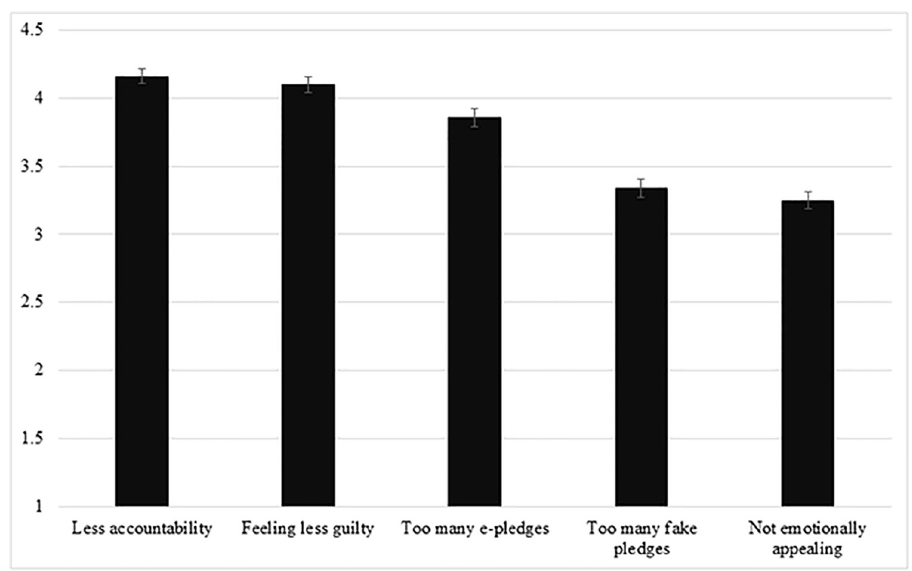
Fig 1. Ratings of factors that contributed to slacktivism, Pilot Study